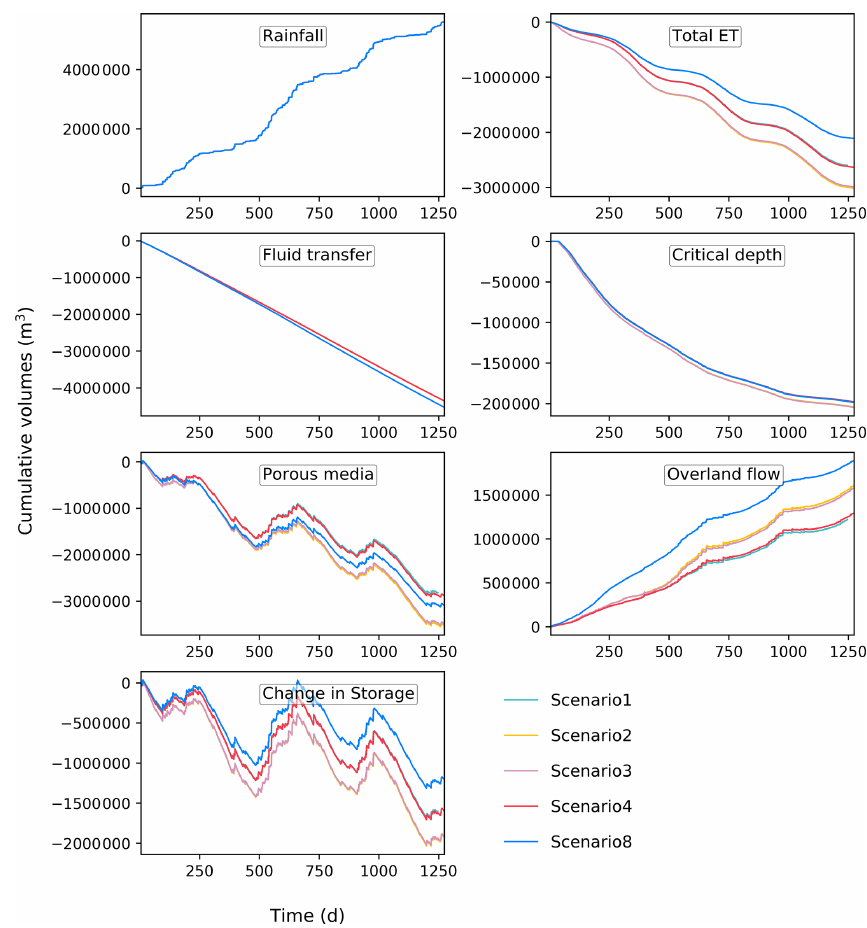
Figure 6. Cumulative values of the water balance components simulated with HydroGeoSphere for scenarios 1–4 and